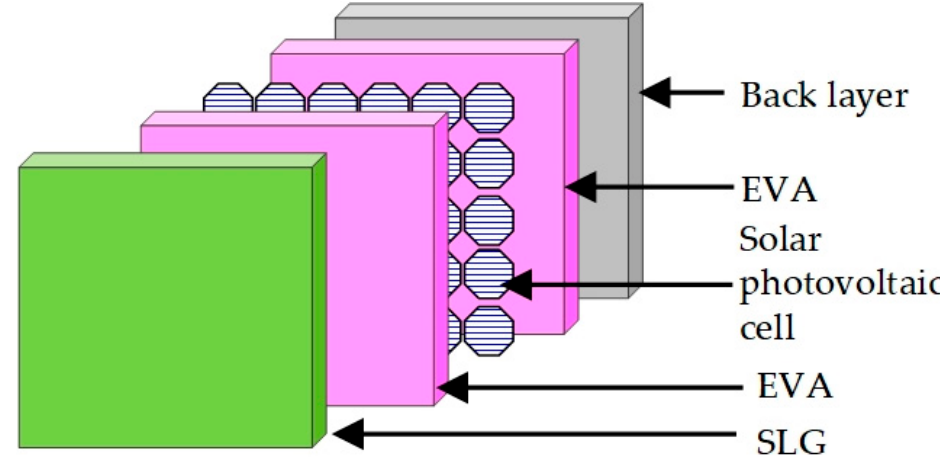
Figure 5. The schematic diagram of SPVM structure.